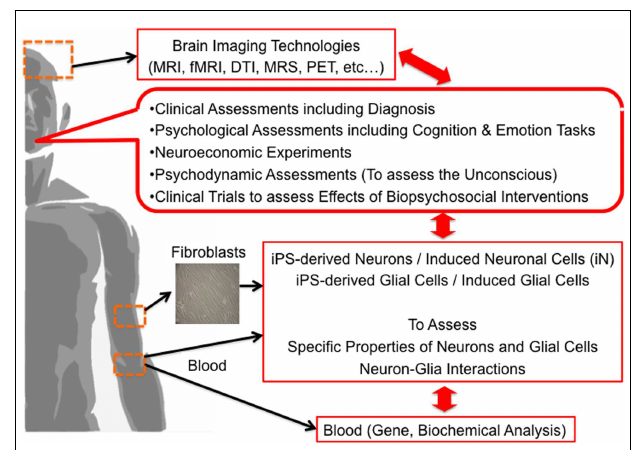
FIGURE 2 |A novel multi-dimensional approach toward psychology & psychiatry